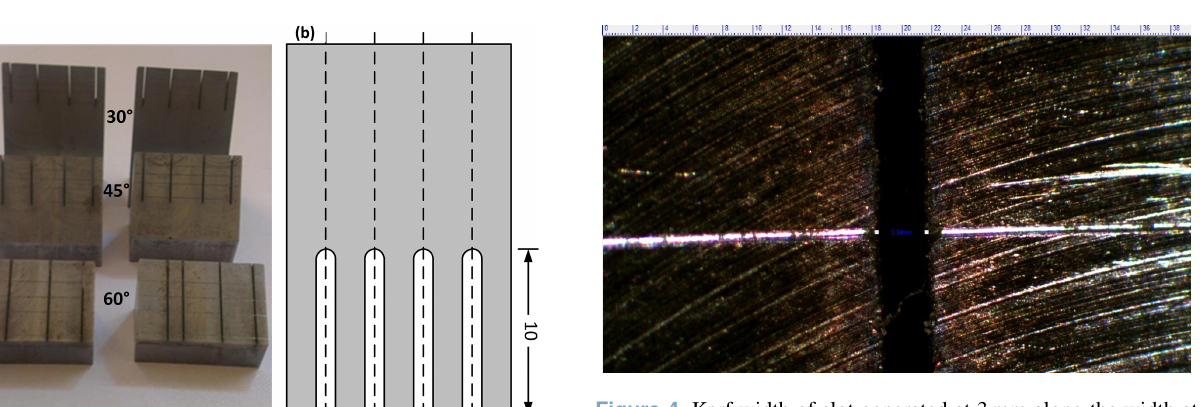
Figure 4. Kerf width of slot generated at 3mm along the width at 45 ◦ taper angle Titanium Alloy workpieces (Cut with pulse-off time of 20µs and